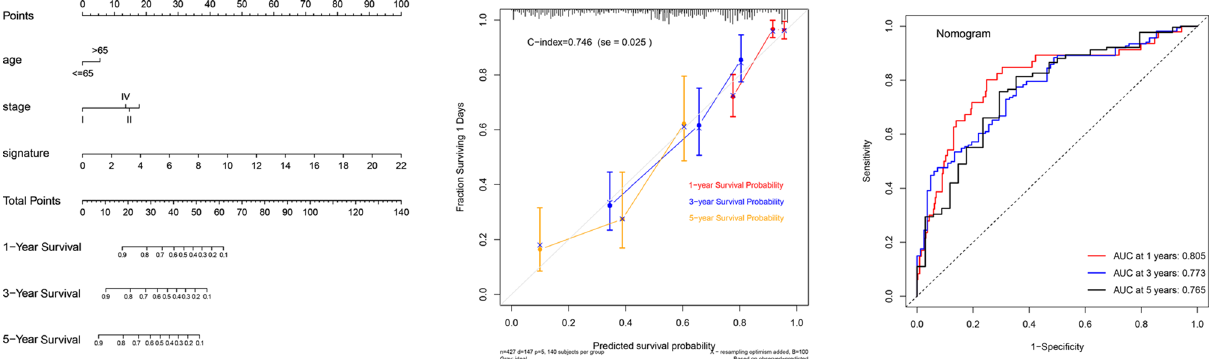
Figure 8. Construction of nomogram. The nomogram contained age, stage, signature containing ten stem cell- related genes. The x-axis of the calibration chart was the predicted recurrence probability result, and the y-axis was the actual recurrence probability. ROC analysis detected the accuracy of prediction and inspection.